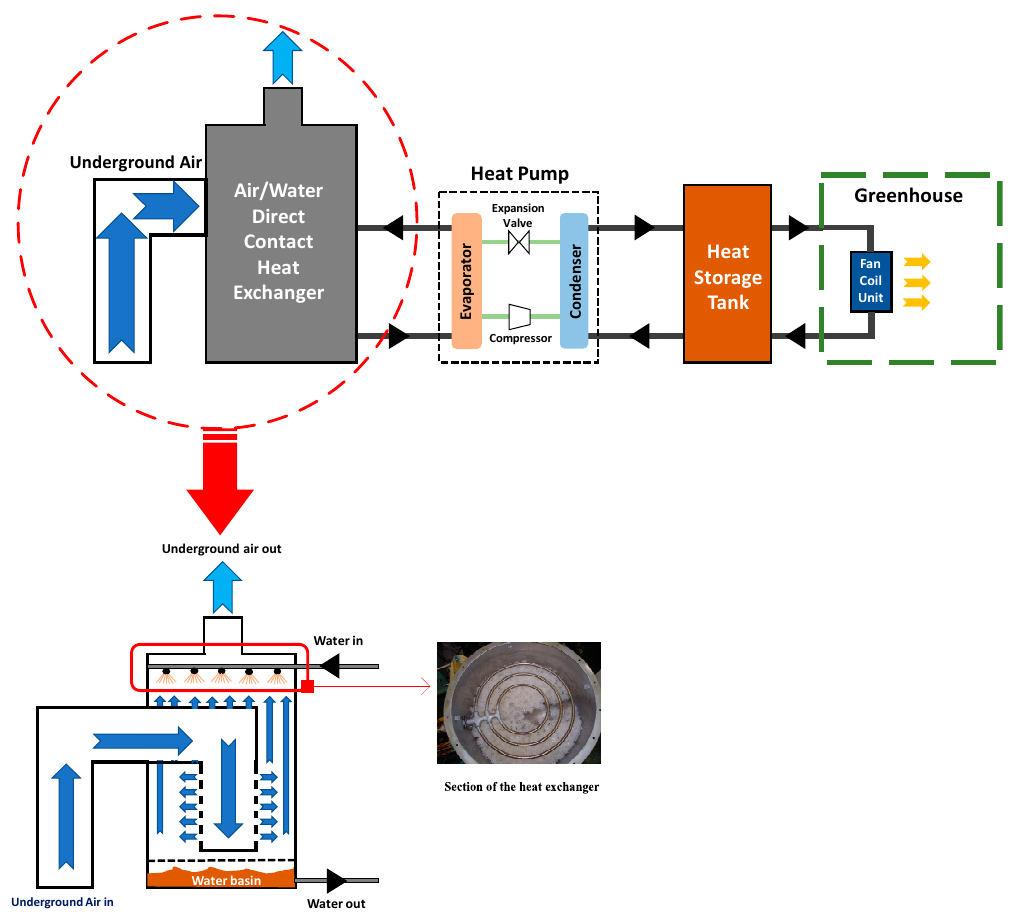
Figure 1. A schematic diagram of the AWHP.